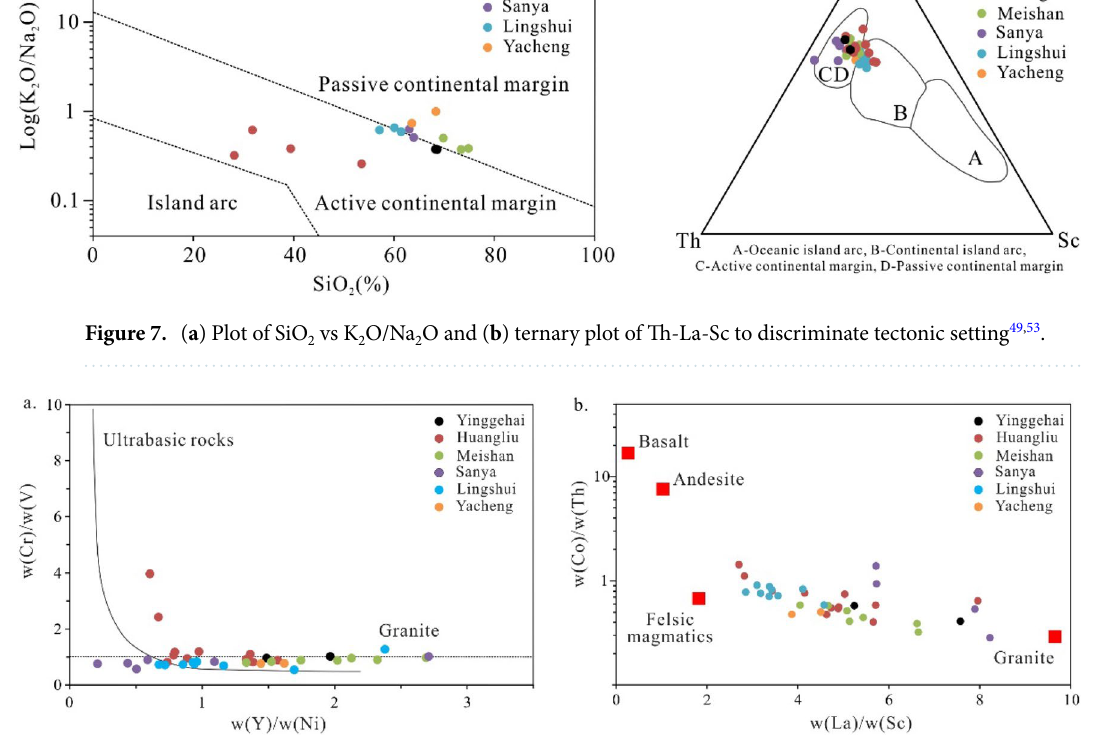
Figure 8. ( a ) Plot of Cr/V vs Y/Ni and ( b ) plot of Co/Th vs